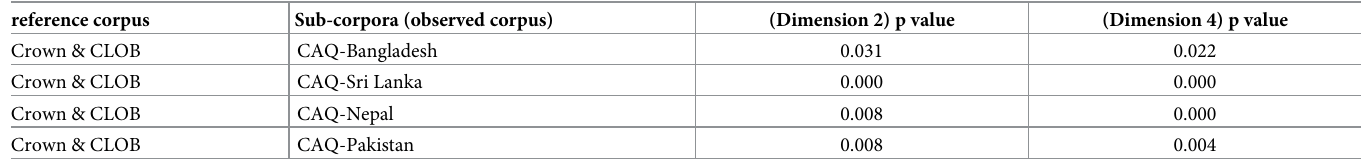
Table 4. The significantly different